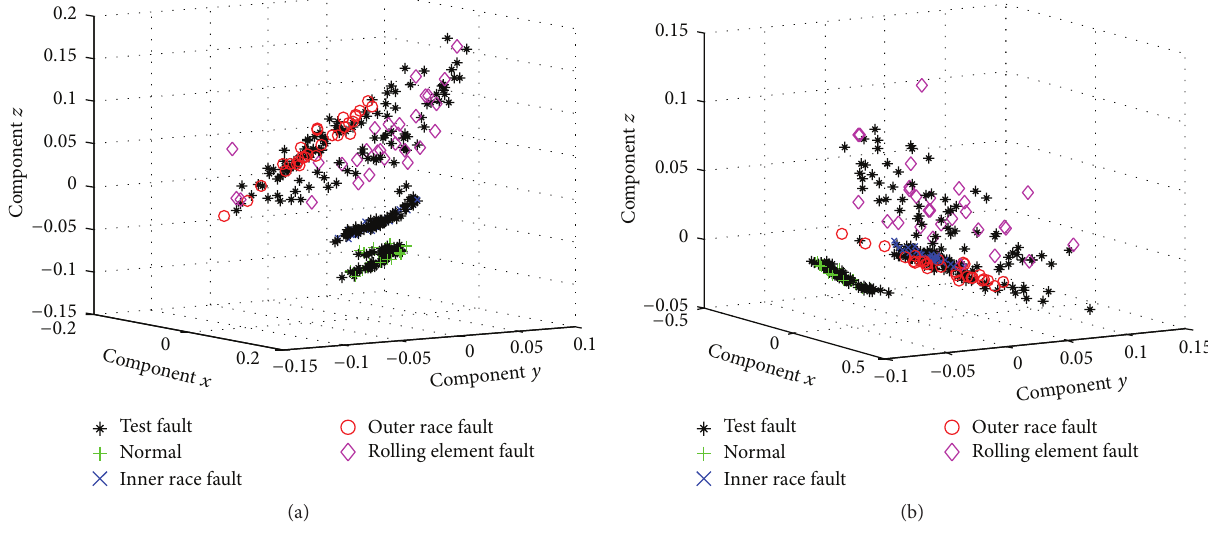
Figure 8: Comparison of dimension reduction after the decomposition of VMD and EMD. Table 4: Comparison of classification accuracy with four different parameters.